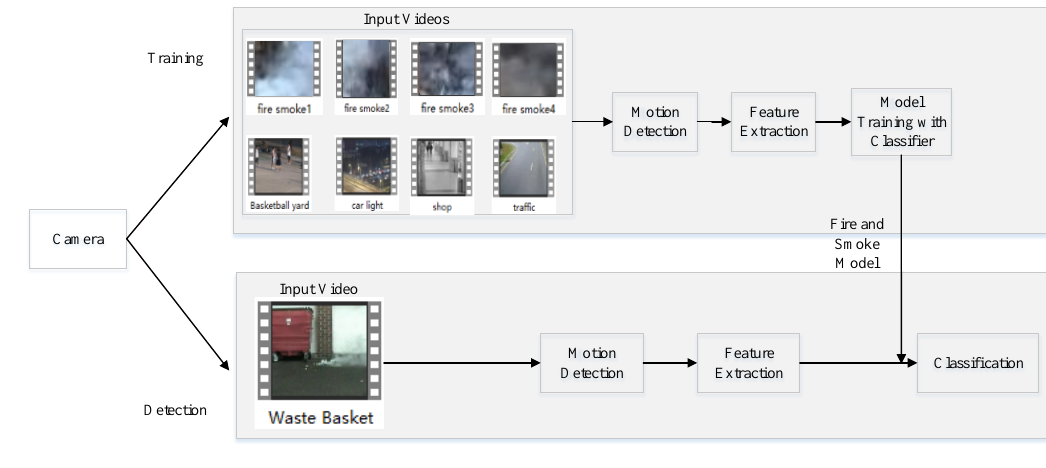
Figure 6. Framework of fire smoke